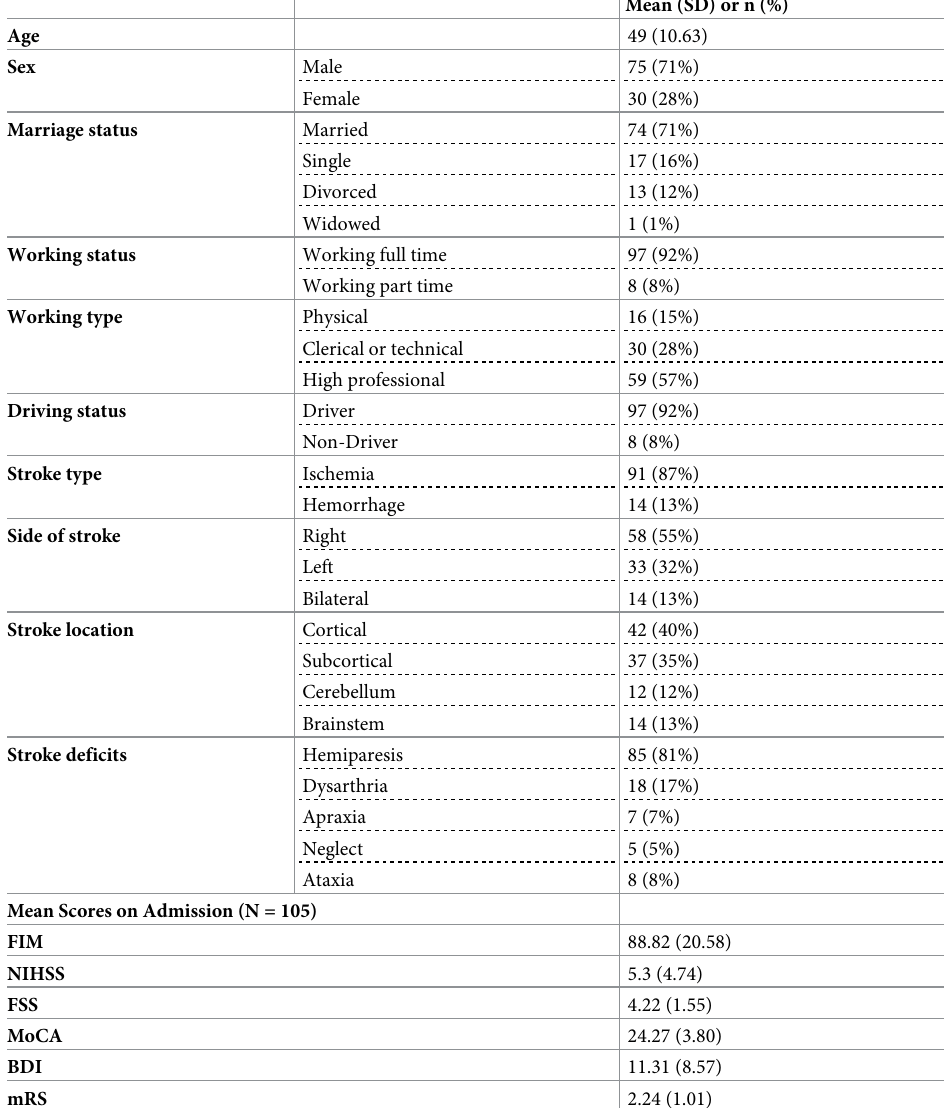
Table 1. Demographic and stroke